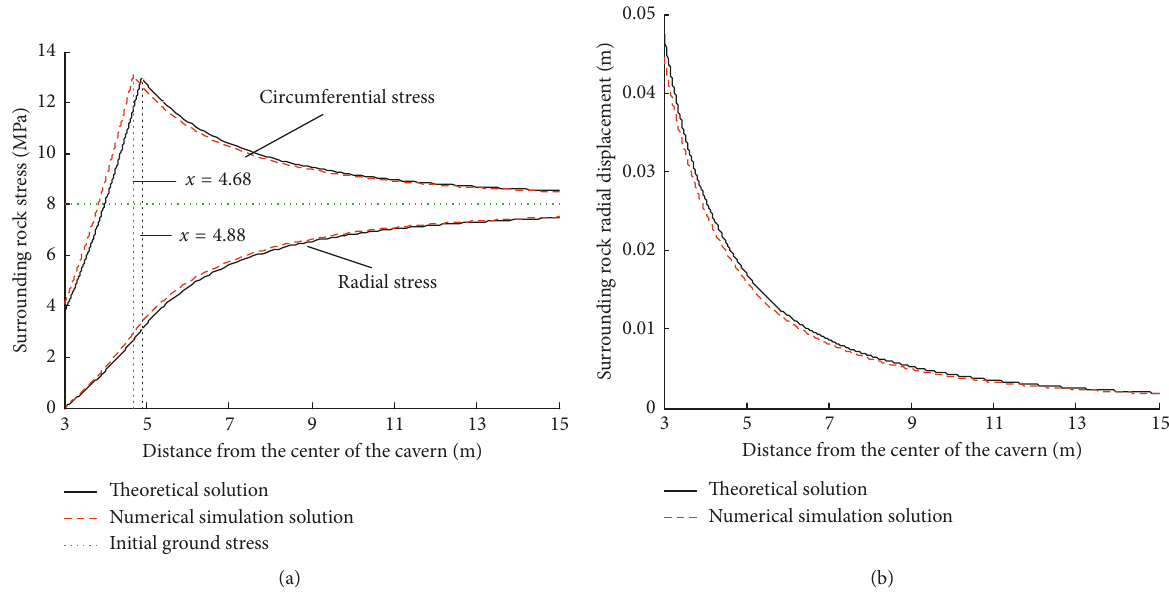
Figure 7: Comparison of the theoretical solution and numerical simulation results: (a) stress comparison; (b) displacement